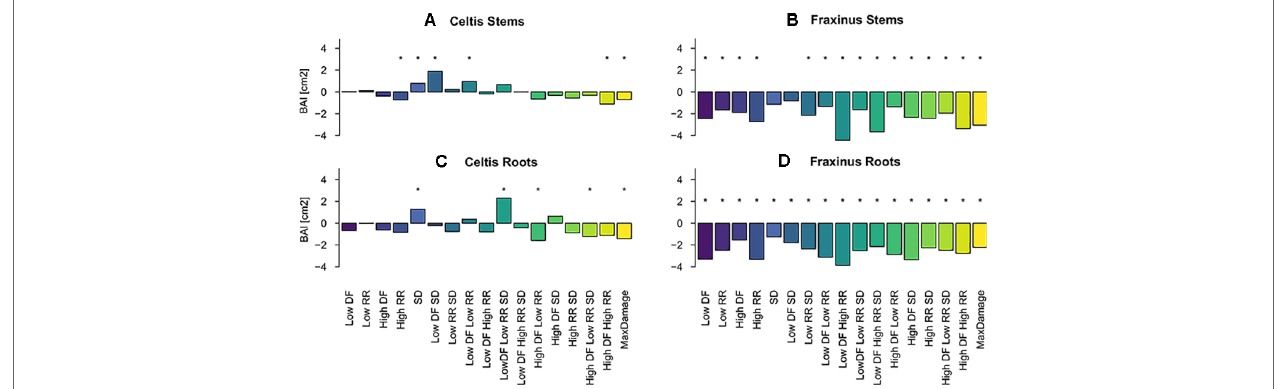
FIGURE 4 | Estimated coefficients of the linear model effect sizes for basal area increment (BAI) growth of Celtis ( A for stem and C for roots) and Fraxinus ( B stem and D for roots) in the period 2012–2015 (years following last damage treatment), and in relation to the damage treatment level (1–18 treatments are color-coded; DF, defoliation; RR, root reduction; and SD = stem damage, indicated as low = 37% damage and high = 75% damage). r ² ~0.1 for all models. For simplicity, asterisks in the figure indicate a significant effect of the variable for P < 0.05, discrimination between significance levels can be found in Table S.1 . The standard deviations for the random effects for the year and the tree id were Celtis stems: 0.9 and 1.09, Fraxinus stems: 1.53 and 1.8, Celtis roots: 0.3 and 1.9, Fraxinus roots: 0.76 and